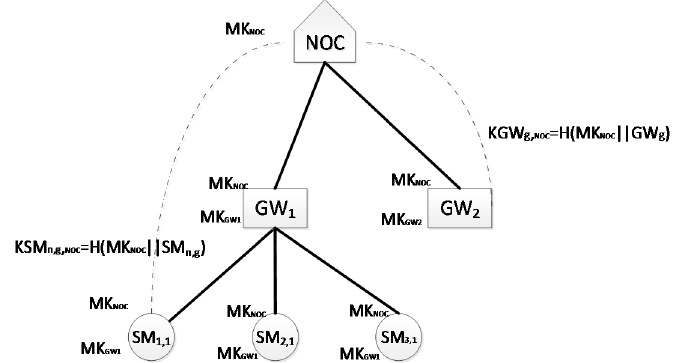
Figure 4. Pre-deployment for NAN in a star topology.